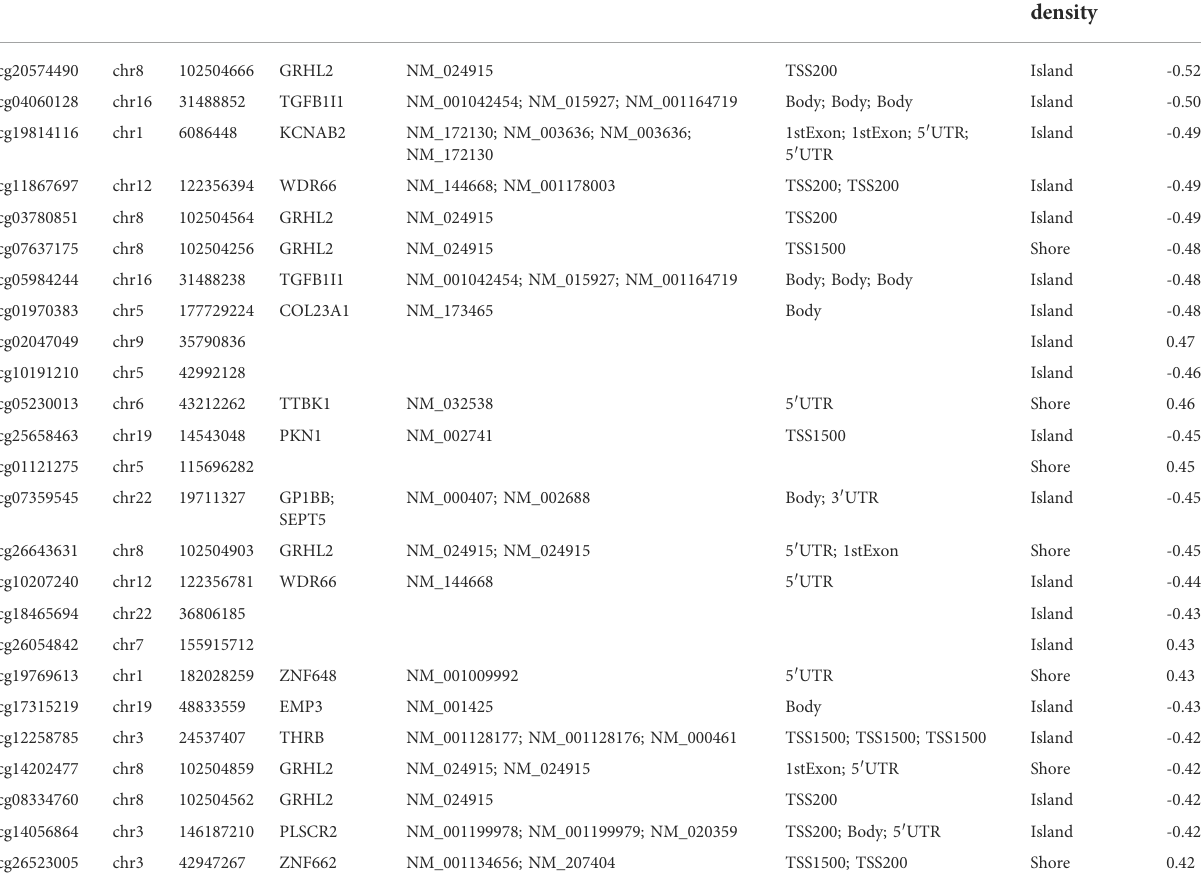
TABLE 4 Top 25 signi fi cant differentially methylated CpGs from promoter CGIs/shore regions belonging to the epigenetic signature that differentiates the ITF of lung metastatic uADC and uLMS. TargetID a Chr b Position Gene name Accession